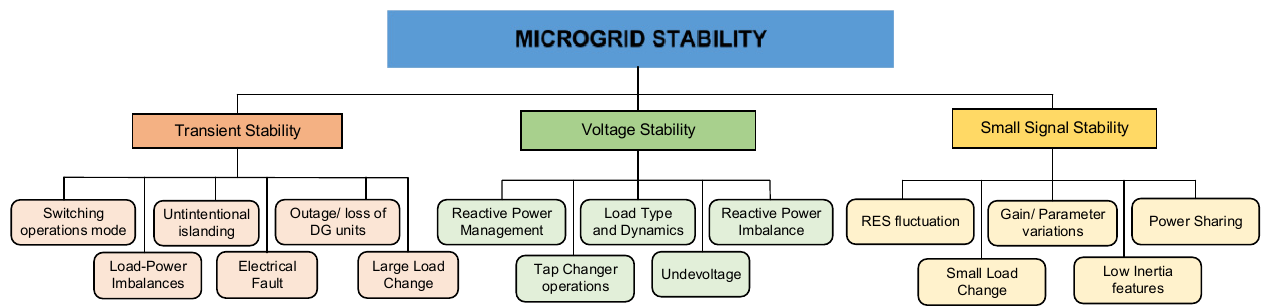
Figure 4. Stability in microgrid [11,30]. Small-signal stability in MGs can arise from various sources such as continuous fluctu- ations of the RE-based system, the feedback controller, the small change in load, parameter variations, and a lack of damping due to the low-inertia characteristics of MG [11].